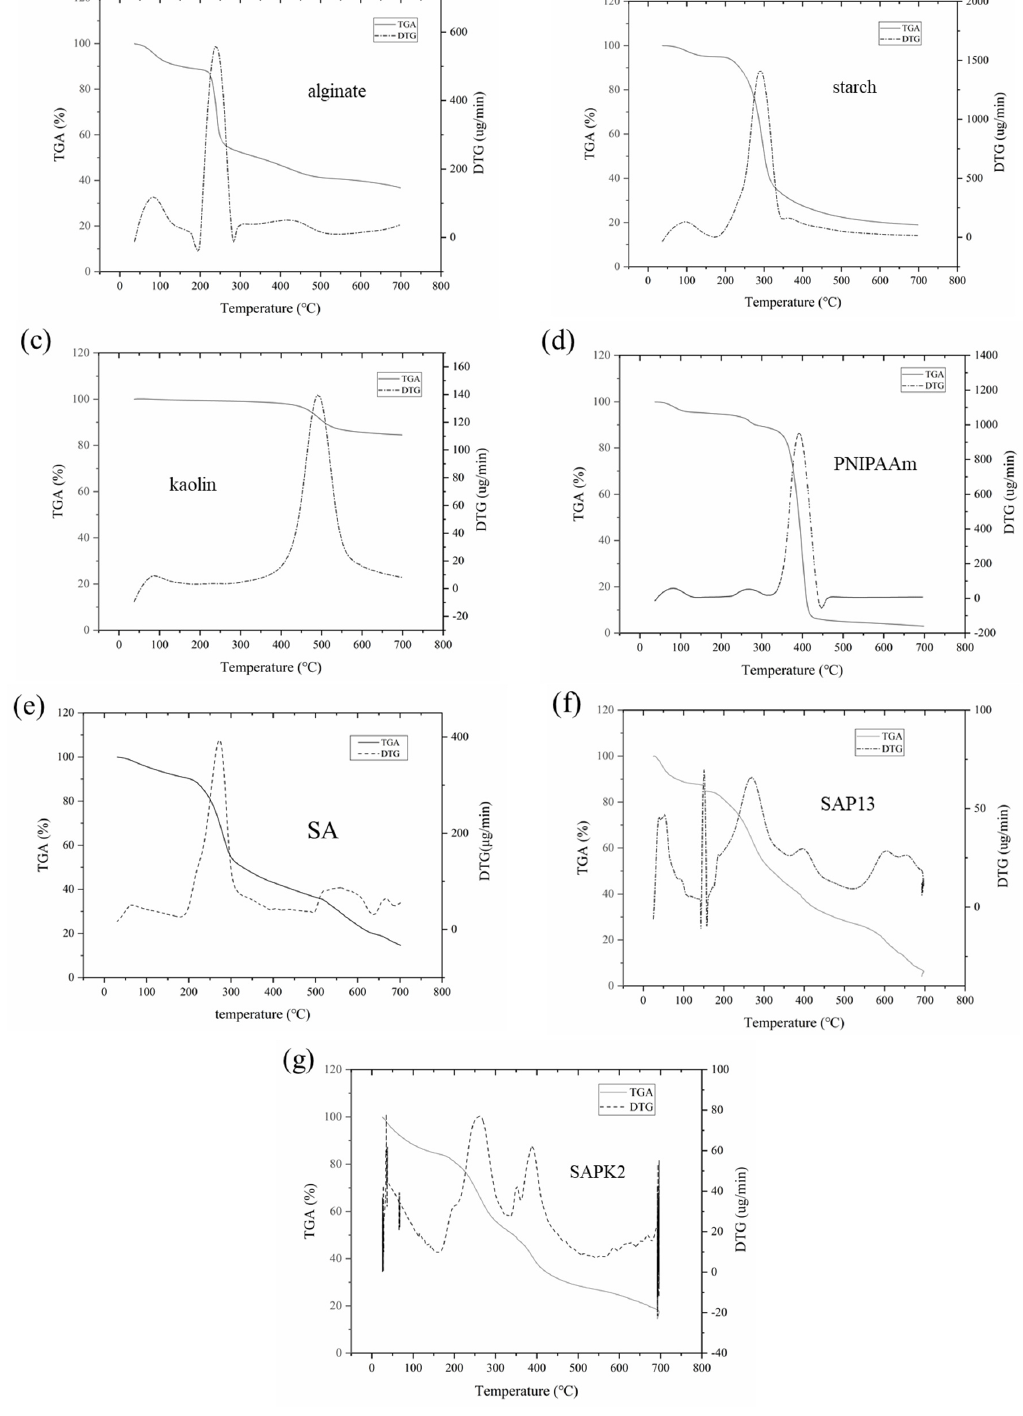
Figure 3. Thermogram of pure components and hydrogel beads: ( a ) alginate, ( b ) starch ( c ), kaolin, ( d ) PNIPAAm, ( e ) SA, ( f ) SAP13, and ( g ) SAPK2.